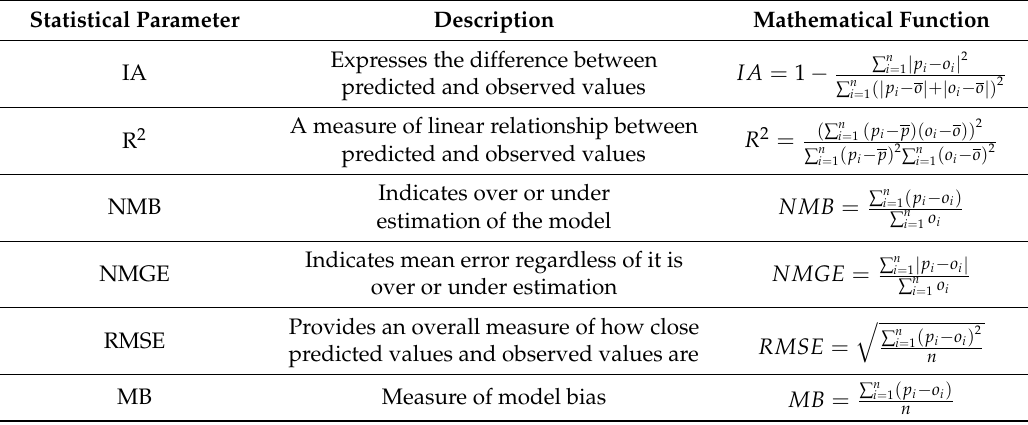
Table 2. Definitions of statistical parameters used for assessing the models